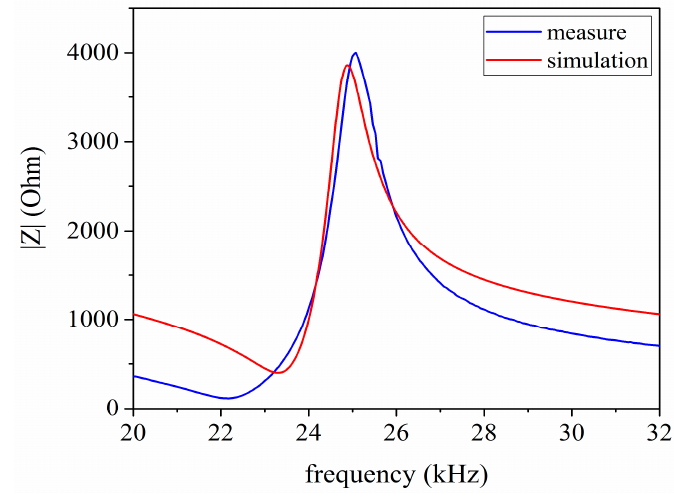
Figure 11. The impedance-frequency relationship of the sandwiched ultrasonic transducer. Table 5. The measured and simulated resonance and anti-resonance frequencies for a sandwich piezoelectric ultrasonic transducer.